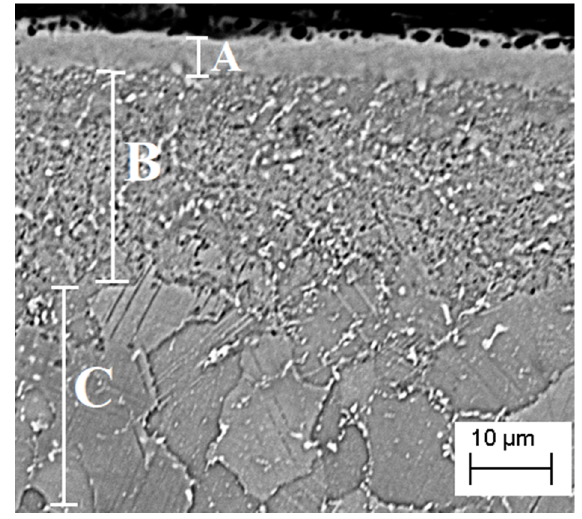
Figure 8. Cross-sectional SEM images of W320 tool steel after electron-beam treatment, plasma nitriding and subsequent electron-beam treatment [41]. (Reproduced with permission from ref. [41]. Copyright (2017), Elsevier).